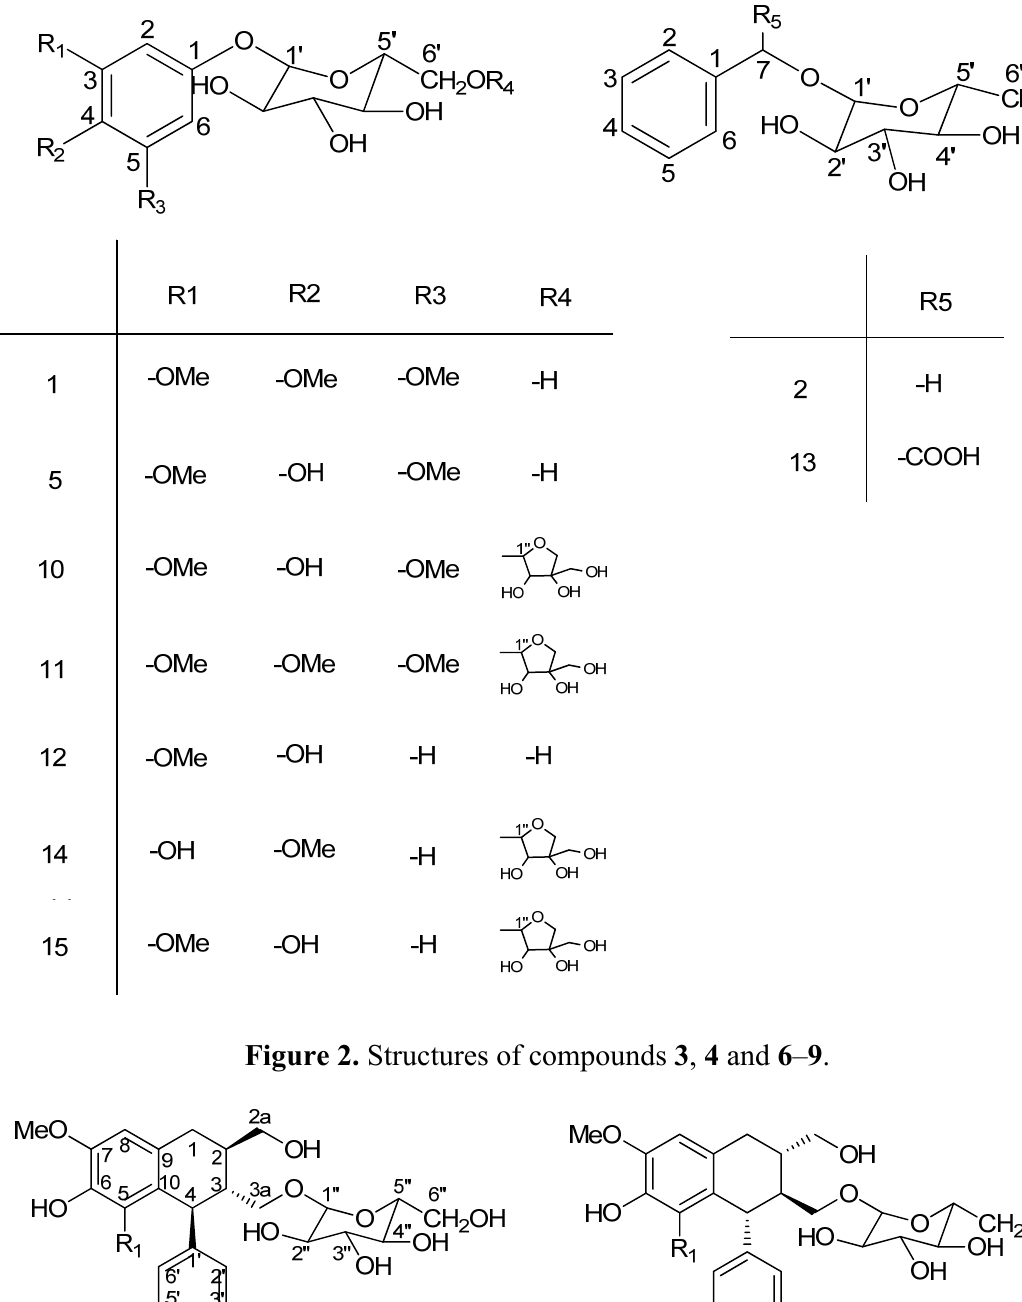
Figure 1. Structures of compounds 1 , 2 , 5 and 10 – 15 .